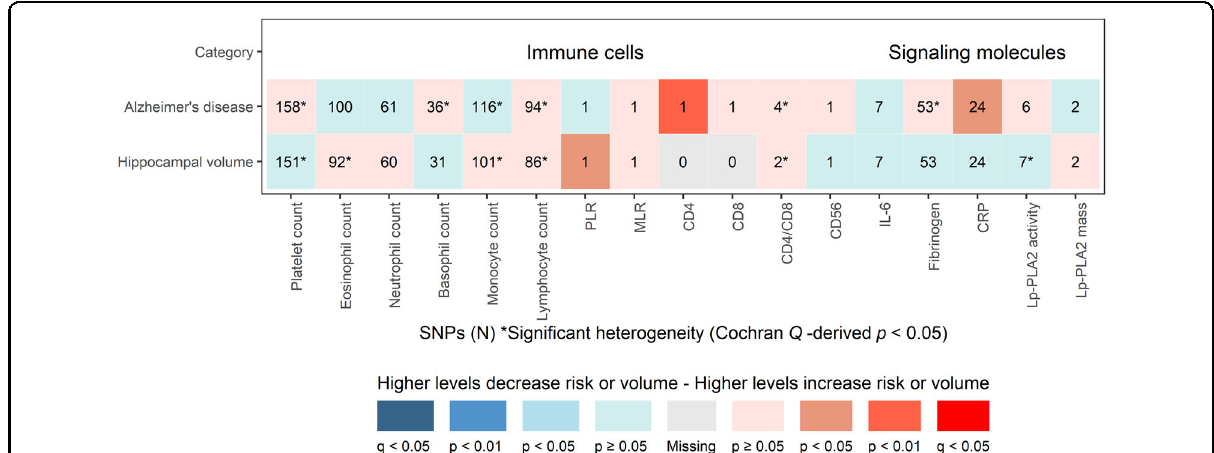
Fig. 1 Primary Mendelian randomization associations of circulating immune cell and signaling molecule levels with Alzheimer ’ s disease and hippocampal volume. Shown are the results derived from the primary inverse variance-weighted meta-analysis. None of the immune cells or signaling molecules survived the multiple testing threshold of false discovery rate < 5% ( q < 0.05). CD, cluster of differentiation; CRP, C-reactive protein; IL, interleukin; Lp-PLA2, Lipoprotein-associated phospholipase A2; MLR, monocyte-to-lymphocyte ratio; PLR, platelet-to-lymphocyte